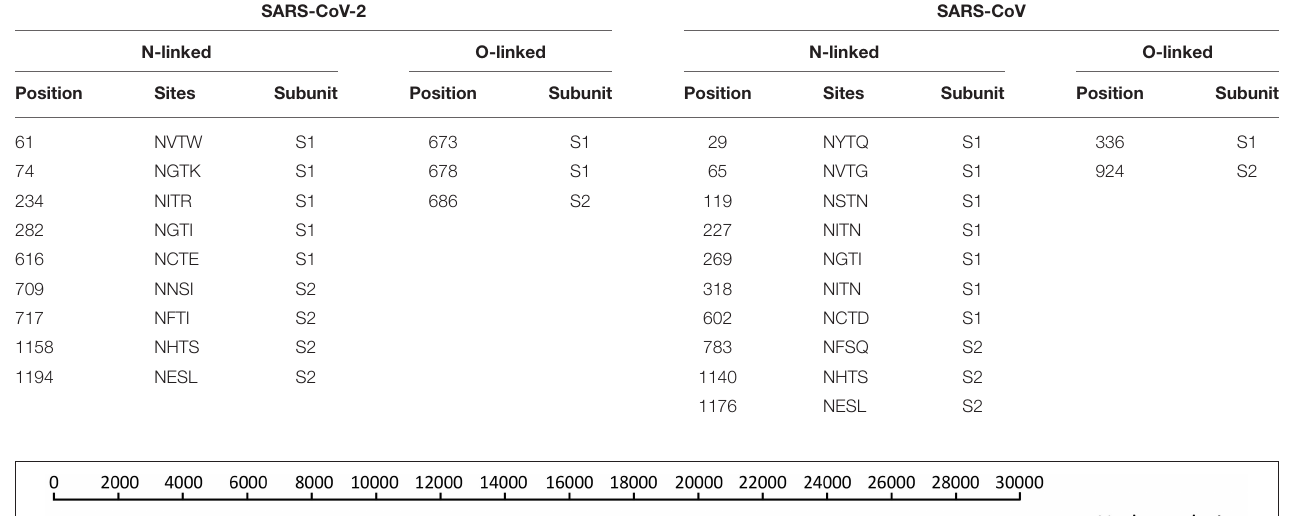
TABLE 4 | Comparison of N- and O-glycosylation sites on spike proteins between SARS-CoV-2 and SARS-CoV. SARS-CoV-2 SARS-CoV O-linked